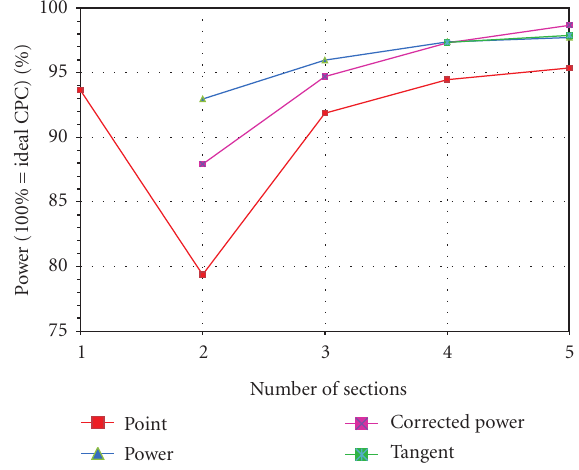
Figure 9: collected power versus number of sections for point- approximated (green), tangent-approximated (orange), power-ap- proximated (blue), and corrected power-approximated CPC